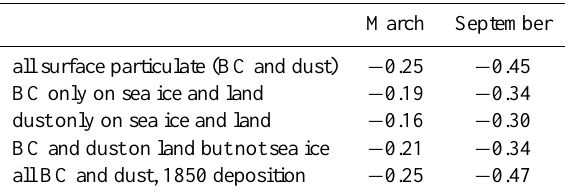
Fig. 10. The seasonal cycles of radiative forcing ( 1F ) and two me- ter air temperature change ( 1T ) for the area North of 60 ◦ N due to light-absorbing particles in snow and sea ice. Table 2. Mean sea ice thickness difference, in meters, for March and September due to light-absorbing